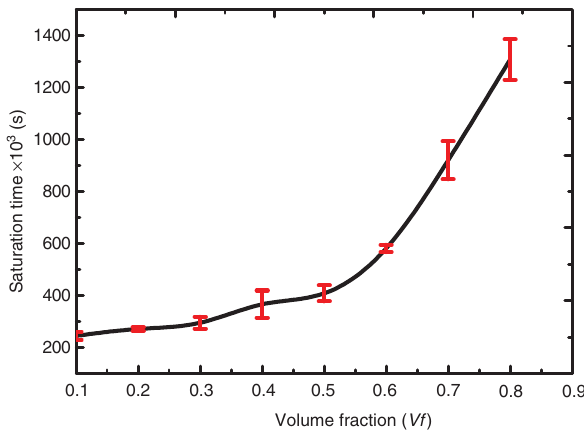
Figure 19: Volume fraction vs. saturation time.